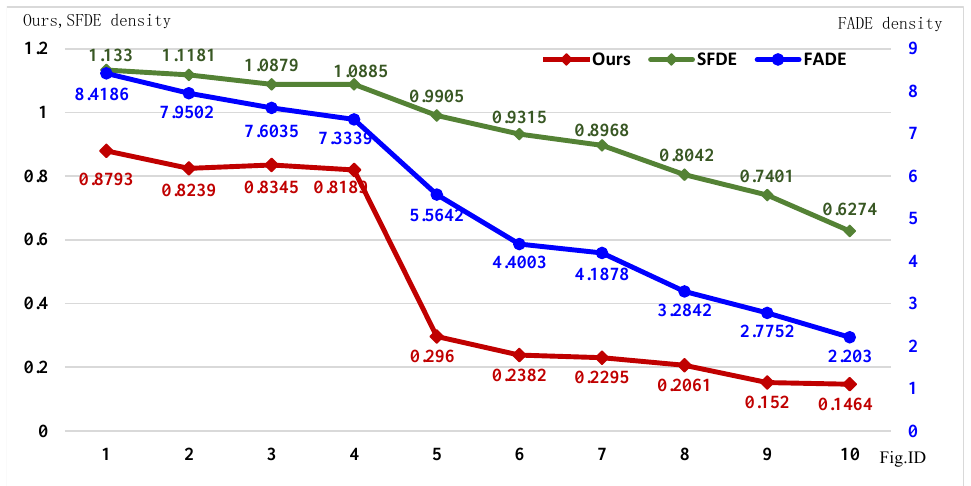
Figure 4. Comparison of the fog density values that were estimated using SFDE [10], FADE [7] and our